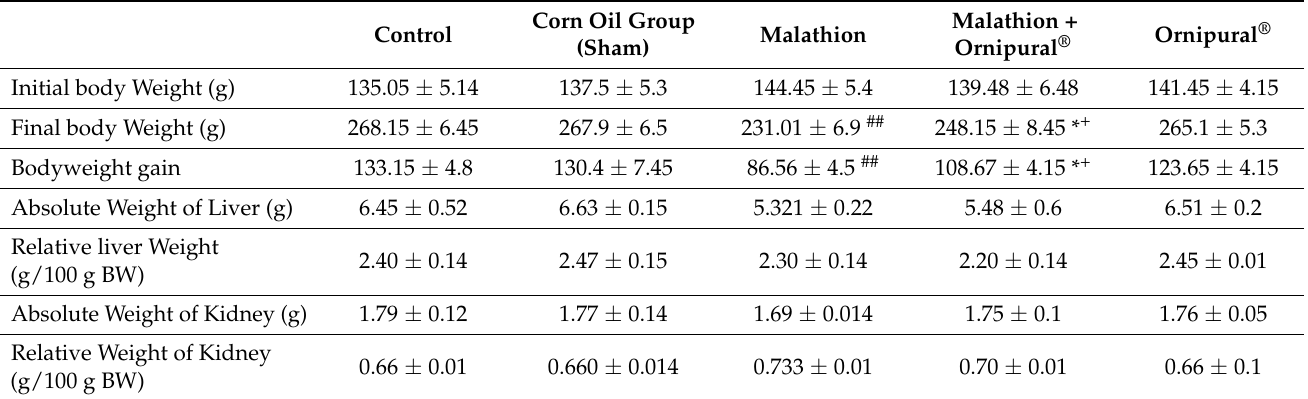
Table 2. Modulatory effect of Ornipural ® against the impact of malathion on growth performance.